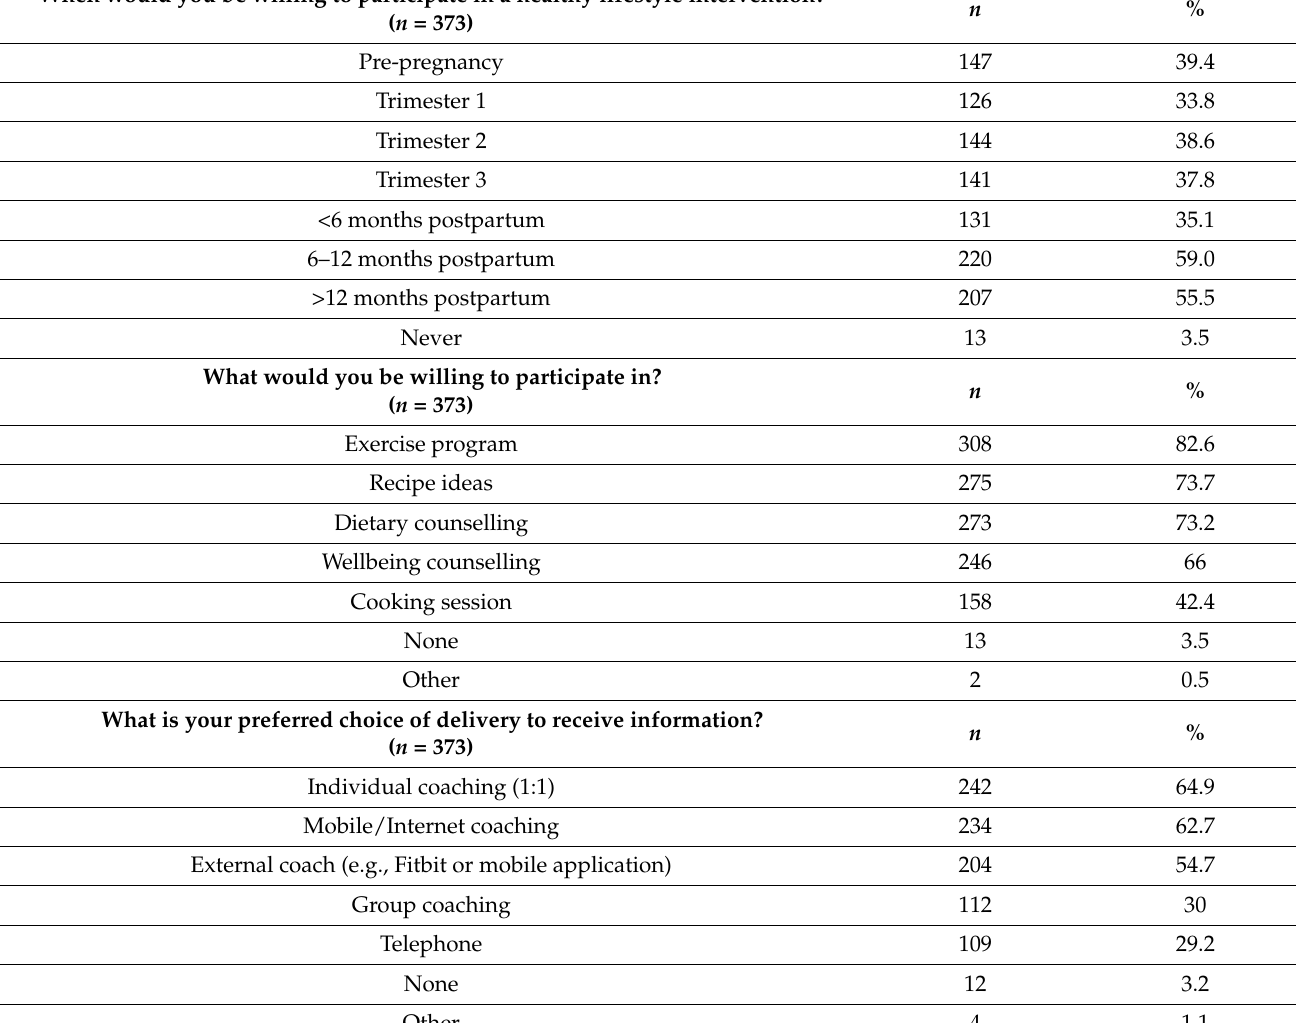
Table 4. Supports and barriers to lifestyle intervention